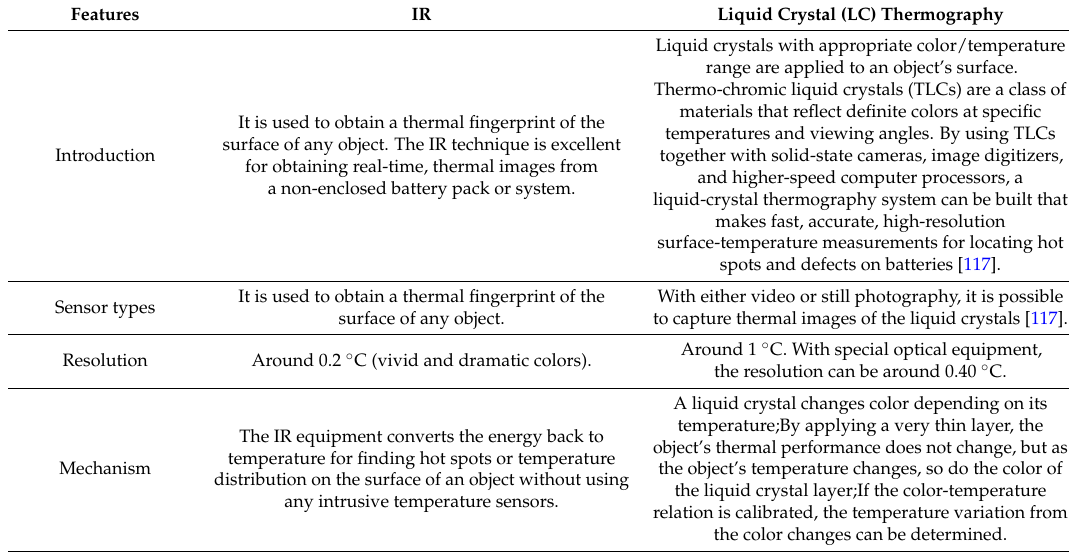
Table 5. Tools used for imaging battery thermal